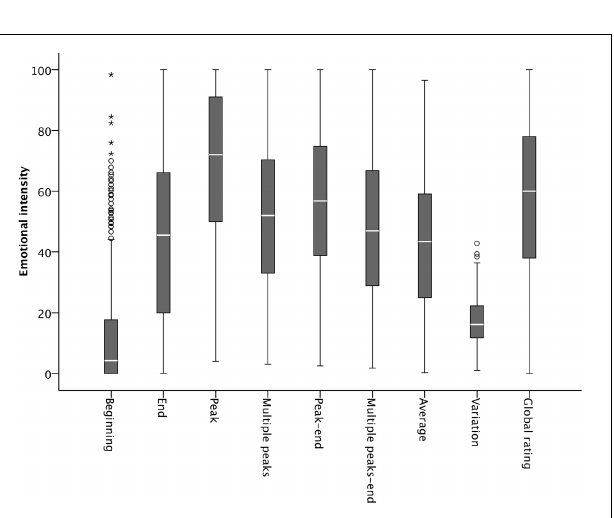
FIGURE 2 | Boxplots showing the distributions of the moment-to-moment parameters and the global rating of emotional intensity, calculated across all participants and all songs. Note that sum and number of multiple peaks are not included because they have a different